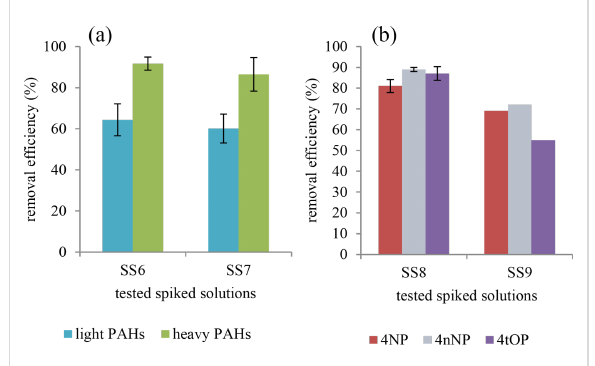
Figure 7: Removal efficiency (%) after treatment with activated polyBTCA-CD (concentration = 2 g·L − 1 ) for (a) two concentrations of PAHs: low for SS6 and high for SS7 ( n = 3) and (b) two concentra- tions of APs: low for SS8 ( n = 3) and high for SS9 ( n = 1) (4NP: 4-nonylphenol, 4nNP: 4- n -nonylphenol, 4tOP: 4- tert